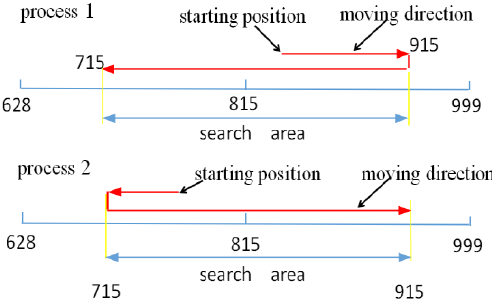
Figure 11. Autofocusing process diagram.